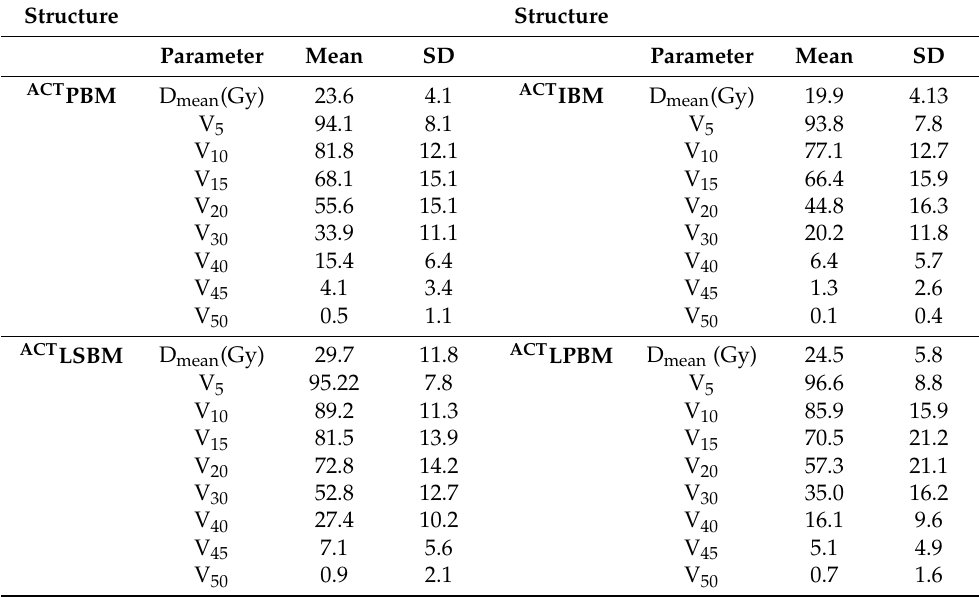
Table 5. Dosimetric parameters for pelvic active bone marrow and its subsites.